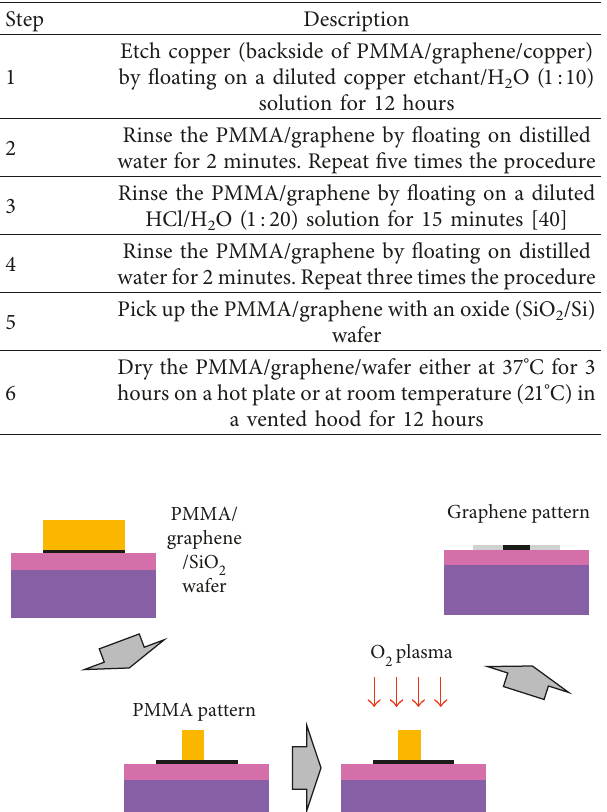
Table 2: Process to transfer the PMMA/graphene from a copper foil to an oxide wafer. Transfer of the PMMA/graphene membrane between recipients is made with a silicon wafer.